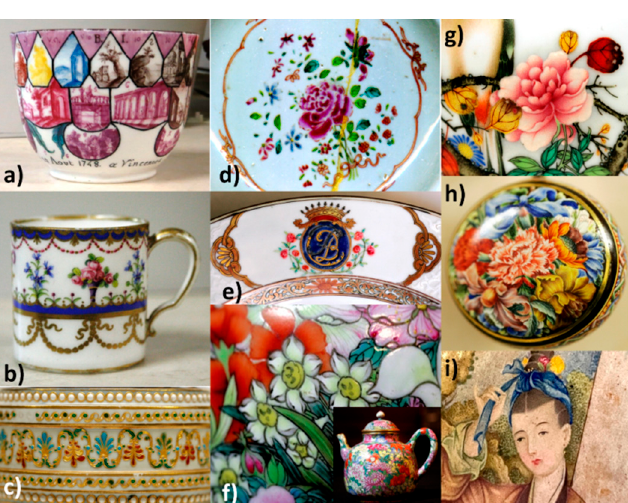
Figure 1. Selection of 18th century objects representative of the variety of colored decorations ob-